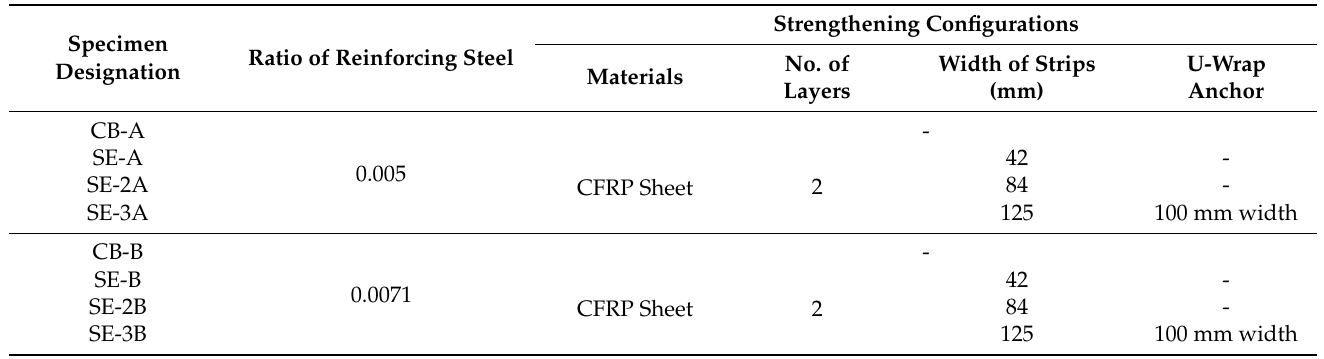
Table 1. Test matrix.